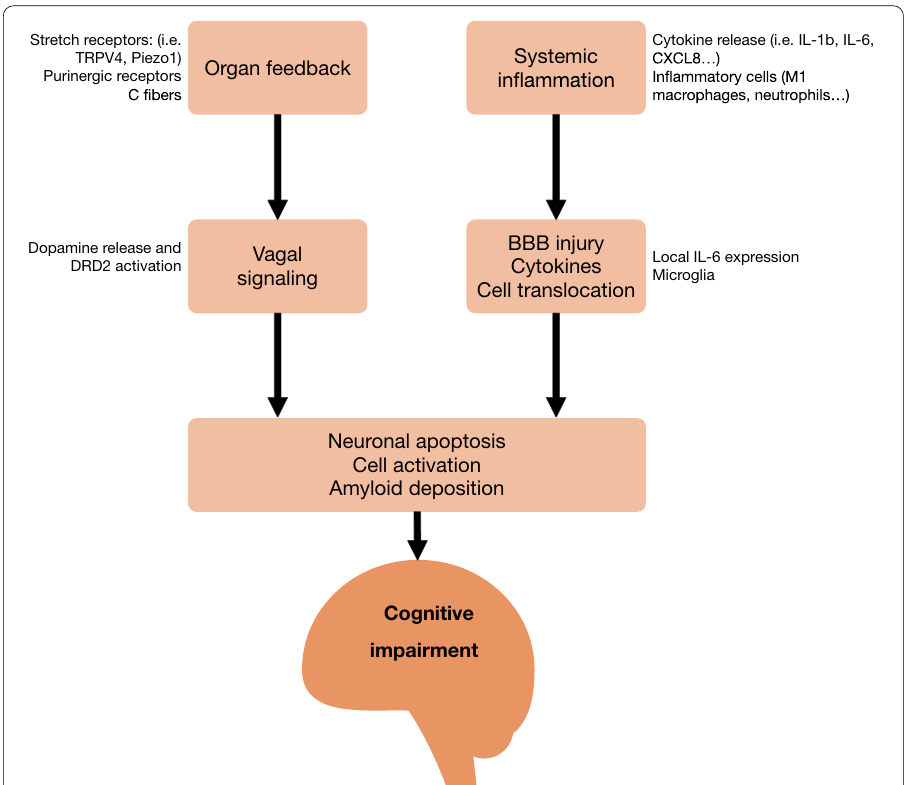
Fig. 3 Mechanisms of brain damage after critical illness. Neural and circulating signals reach the brain during critical illness and trigger several pathogenetic responses, including neuronal apoptosis, cell activation and amyloid deposition, that could explain the long‑term sequelae experienced by ICU